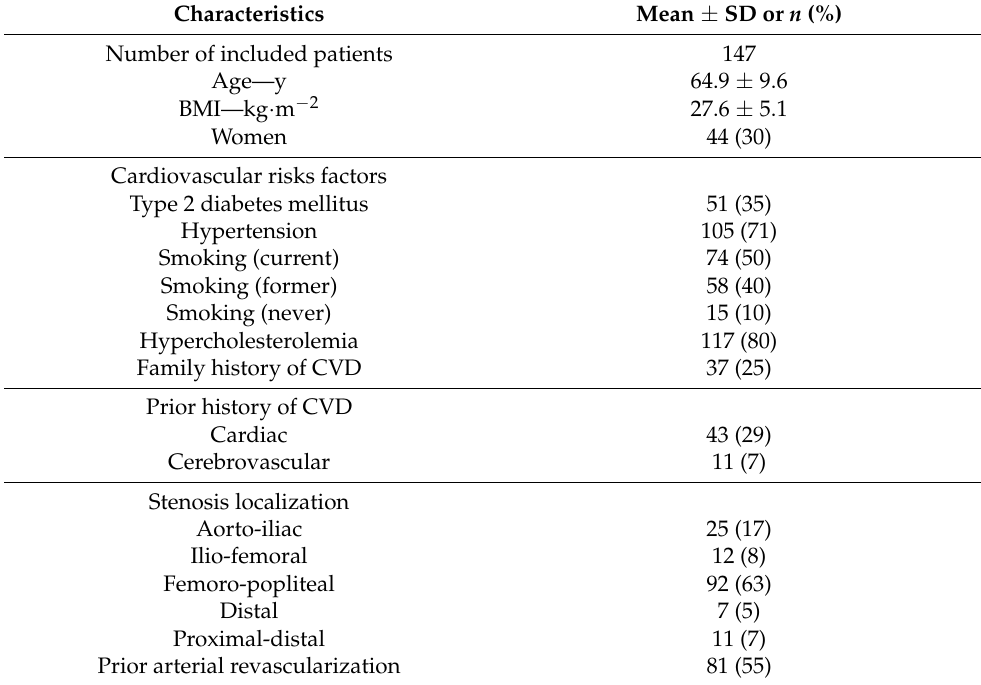
Table 1. Baseline characteristics of the study